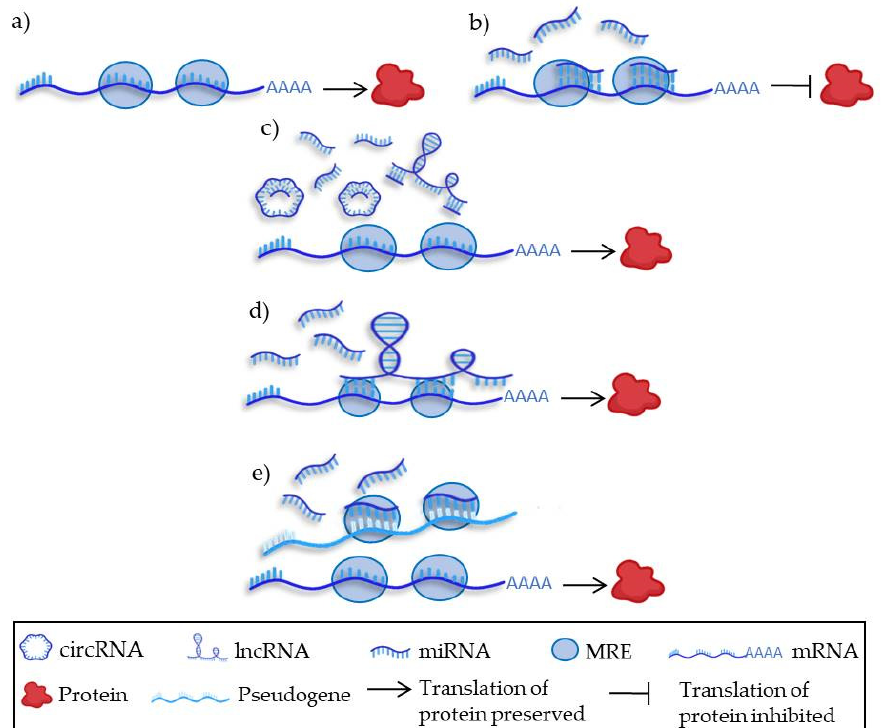
Figure 5. Main models of competing endogenous RNA (ceRNAs). ( a ) mRNAs are rich in MREs; ( b ) miRNAs bind MREs in the 3 ′ UTR of their target mRNAs and inhibit protein translation; ( c ) ncRNAs such as lncRNAs or circRNAs are rich in MREs and can gather miRNAs, reducing the MiRNAs’ inhibitory effect on the translation. ( d ) lncRNAs can block the MREs in mRNAs, impairing the binding of miRNAs and reducing the negative influence on protein translation. ( e ) Pseudogenes can also bind miRNAs, avoiding their effect on the original gene and allowing their translation. circRNA: circular RNA; lncRNA: long non-coding RNA; miRNA: microRNA; MRE: MicroRNA response element; mRNA: messenger RNA.